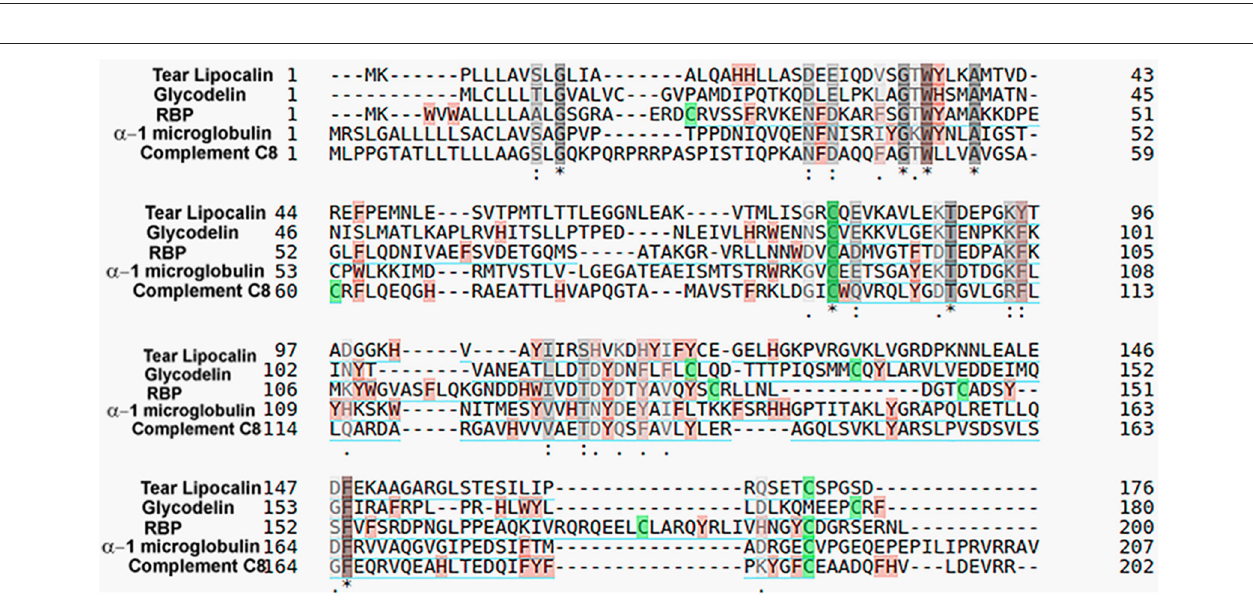
FIGURE 1 | Comparison of solution and crystal structure of tear lipocalin. The solution structure is shown on the left (Gasymov et al., 2001) and the crystal structure is shown on the right (Breustedt et al., 2005), PDB file, 1XKI. The loops (yellow) were evident from the solution structure, but were not resolved by the crystal structure. The strands or β sheets are shown in aqua and the α -helices are shown in red. The loops are named (black) by the adjoining strands for orientation.